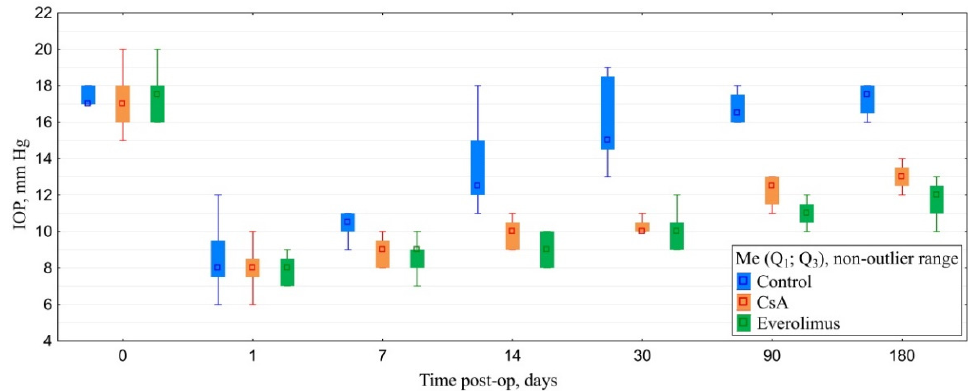
Figure 12. IOP dynamics.